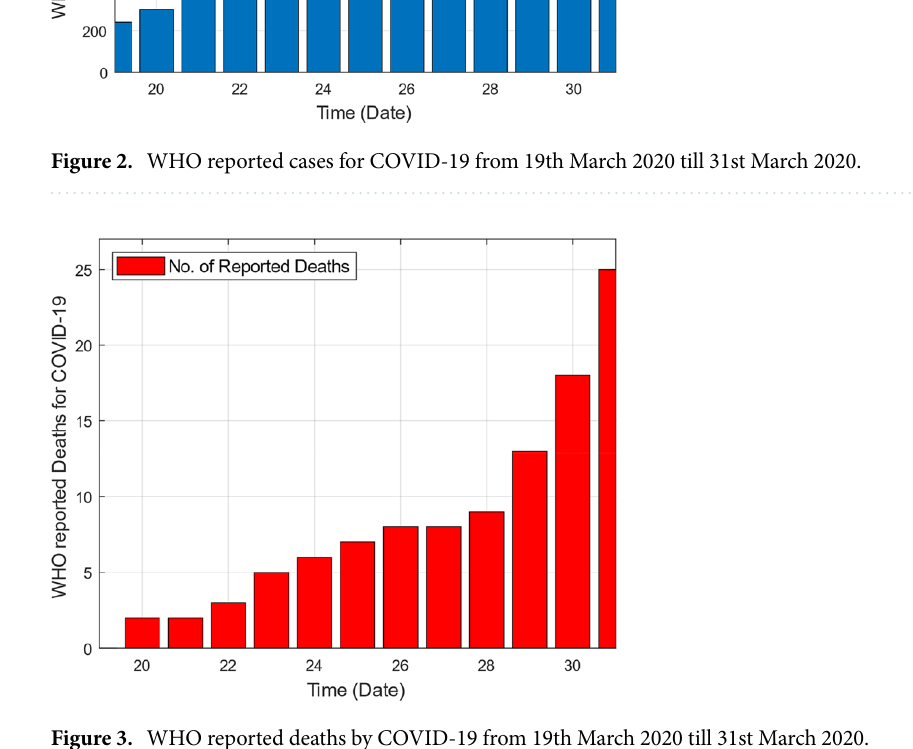
Figure 3. WHO reported deaths by COVID-19 from 19th March 2020 till 31st March 2020.